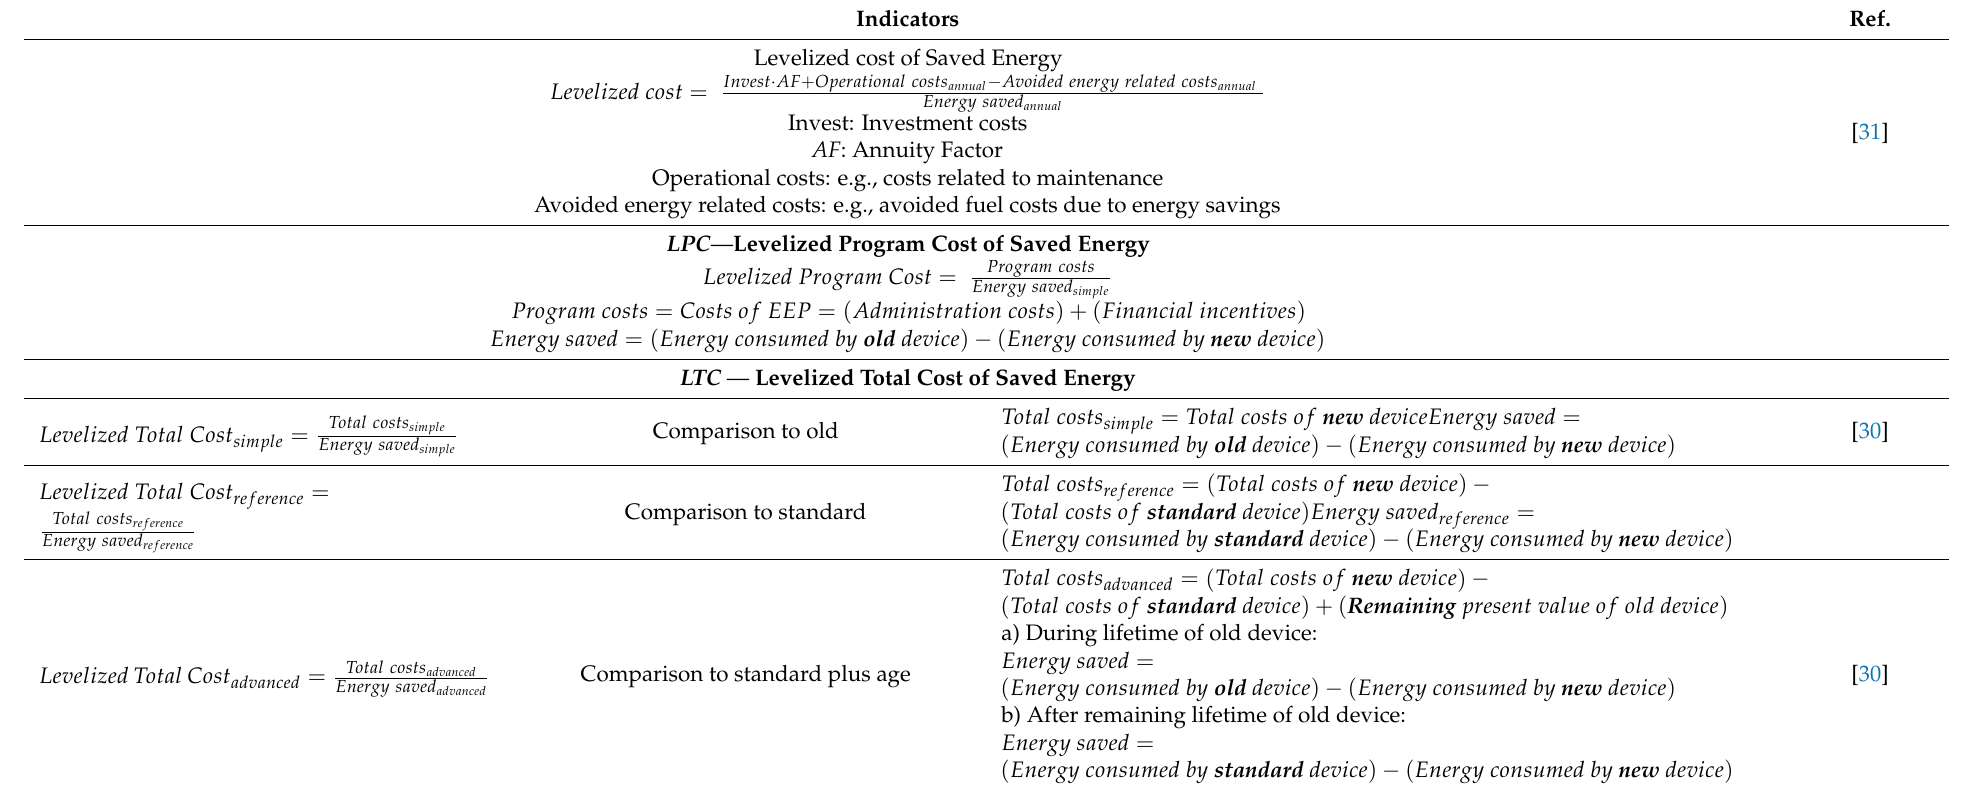
Table 1. Levelised cost indicators used for the evaluation of